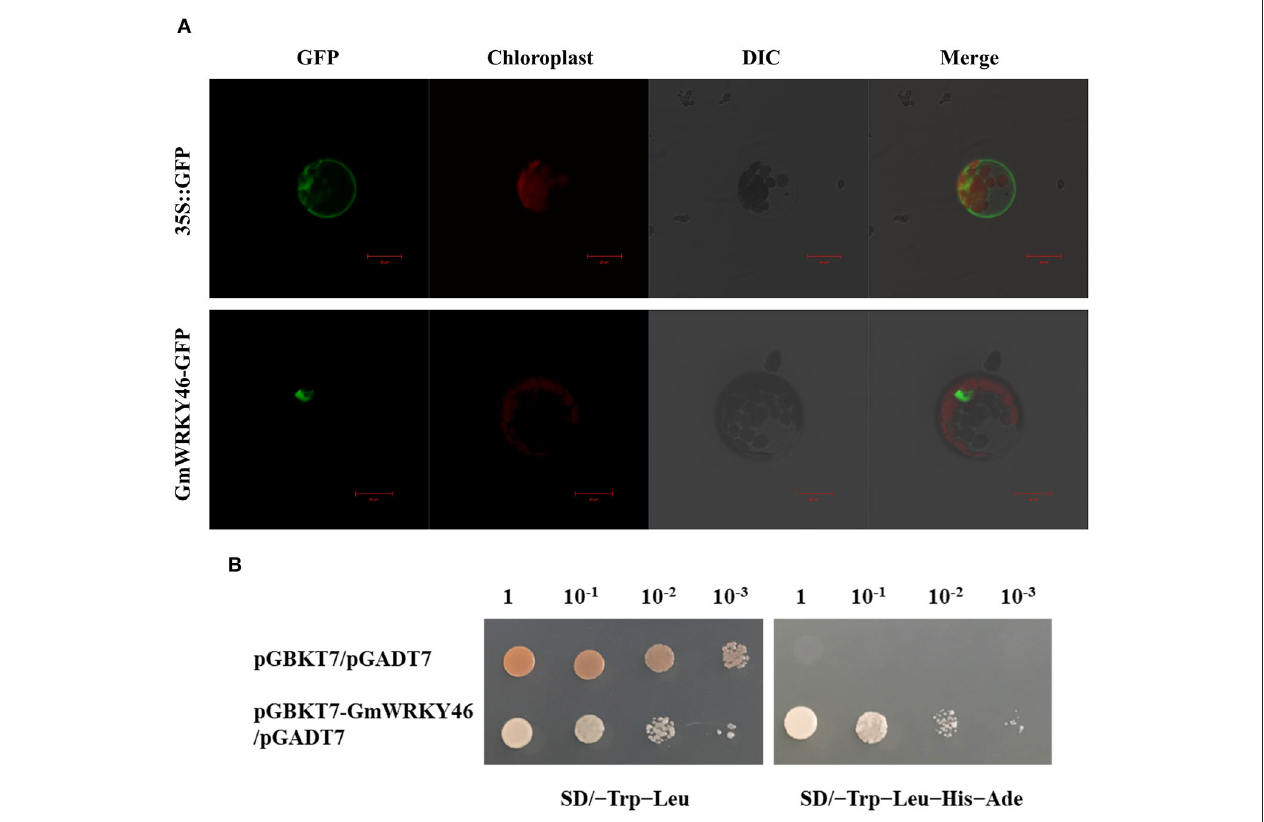
FIGURE 2 | Analysis of subcellular localization and transcription-activating activities of GmWRKY46. (A) Subcellular localization of GmWRKY46-GFP and 35S::GFP protein in Arabidopsis protoplasts. Scale bar = 20 µ m. (B) Y2H assay for transcription-activating activities of GmWRKY46. Yeast cells co-transformed with pGBKT7-GmWRKY46/pGADT7 were grown on selective media SD/-Trip-Leu and SD/-Trip-Leu-His-Ade. Empty pGBKT7/pGADT7 was used as